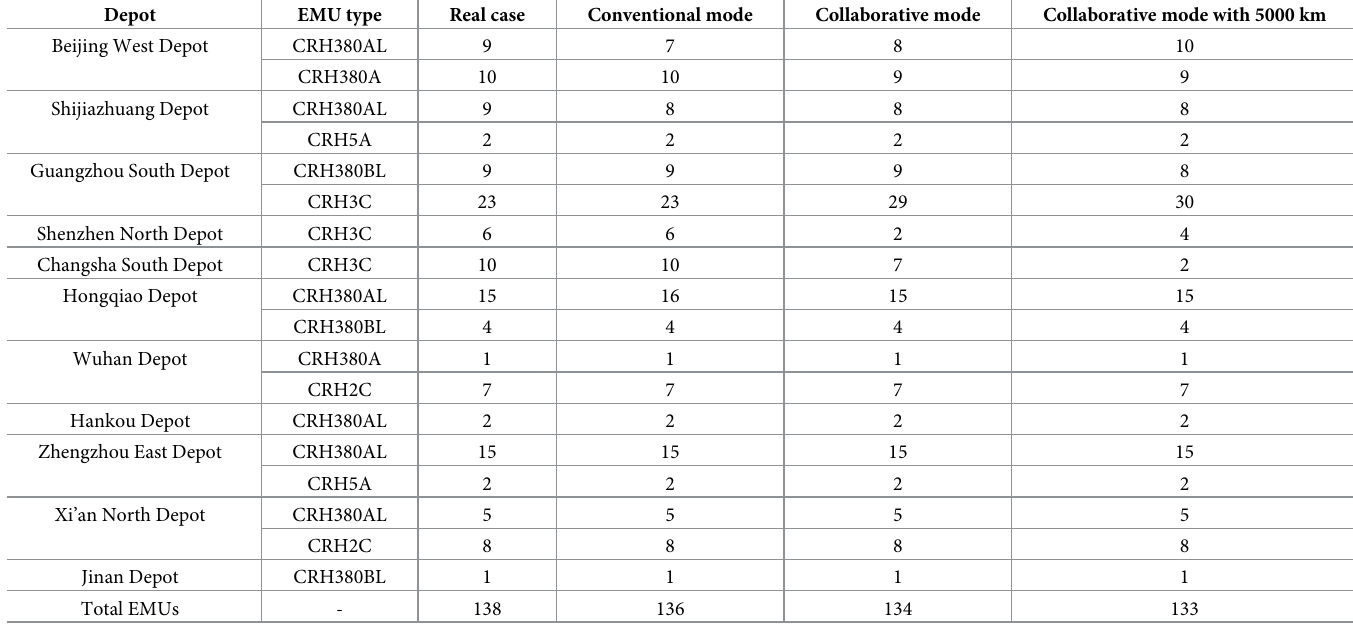
Table 11. Number of EMUs used by each depot in each EMU maintenance management mode. Depot